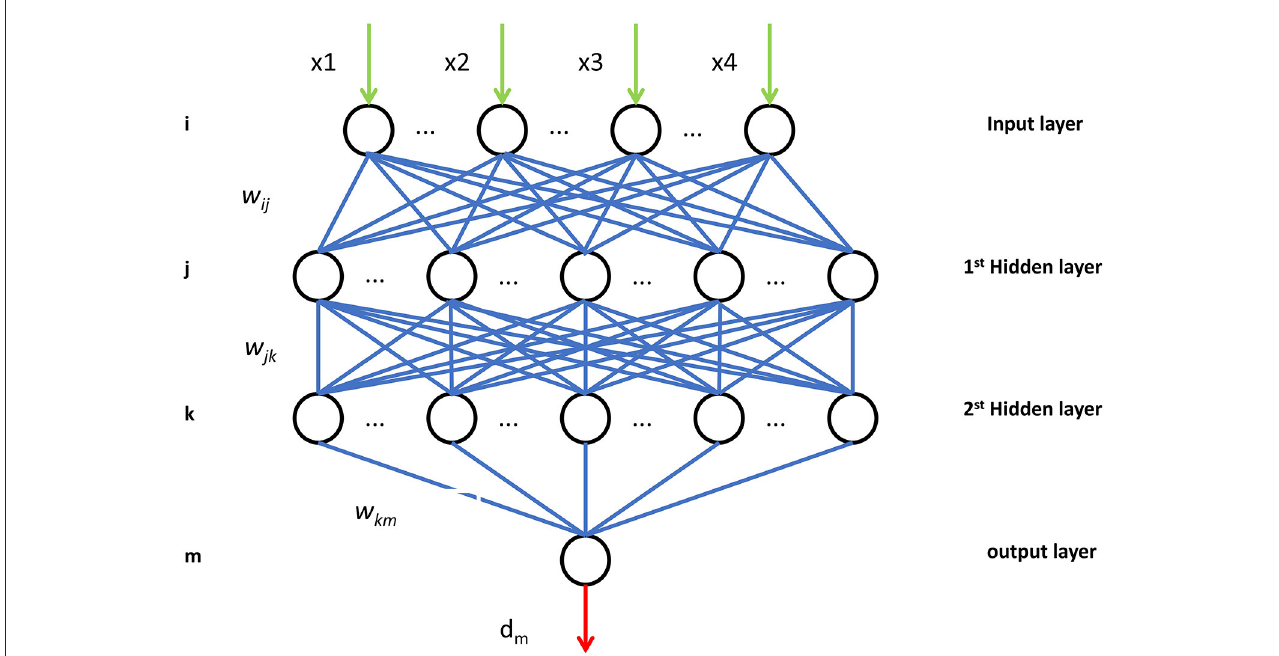
FIGURE1 Structure diagram of four-layer BPNN. BPNN, back propagation neural network.